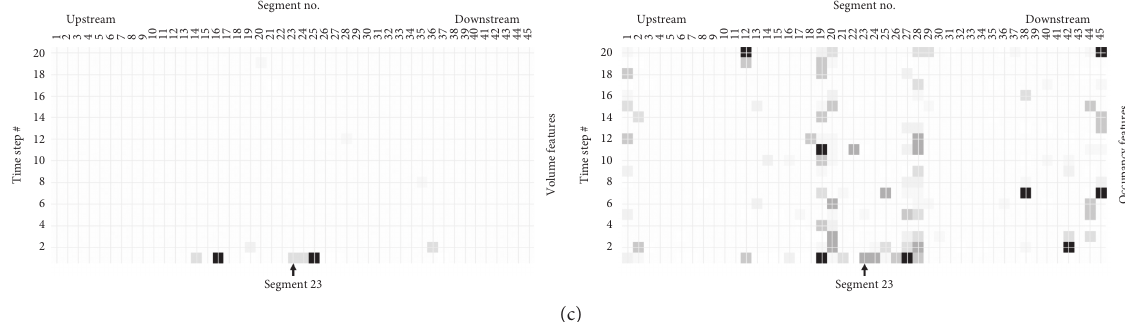
Figure 8: Ranking of attributes in terms of their relative importance to the performance of ANN models, for each of the three different input data aggregation levels (segment 23). The plots for the volume features are on the left and those for the occupancy features are on the right. (a) 30 sec aggregation level. (b) 5min aggregation level. (c) 15min aggregation level.